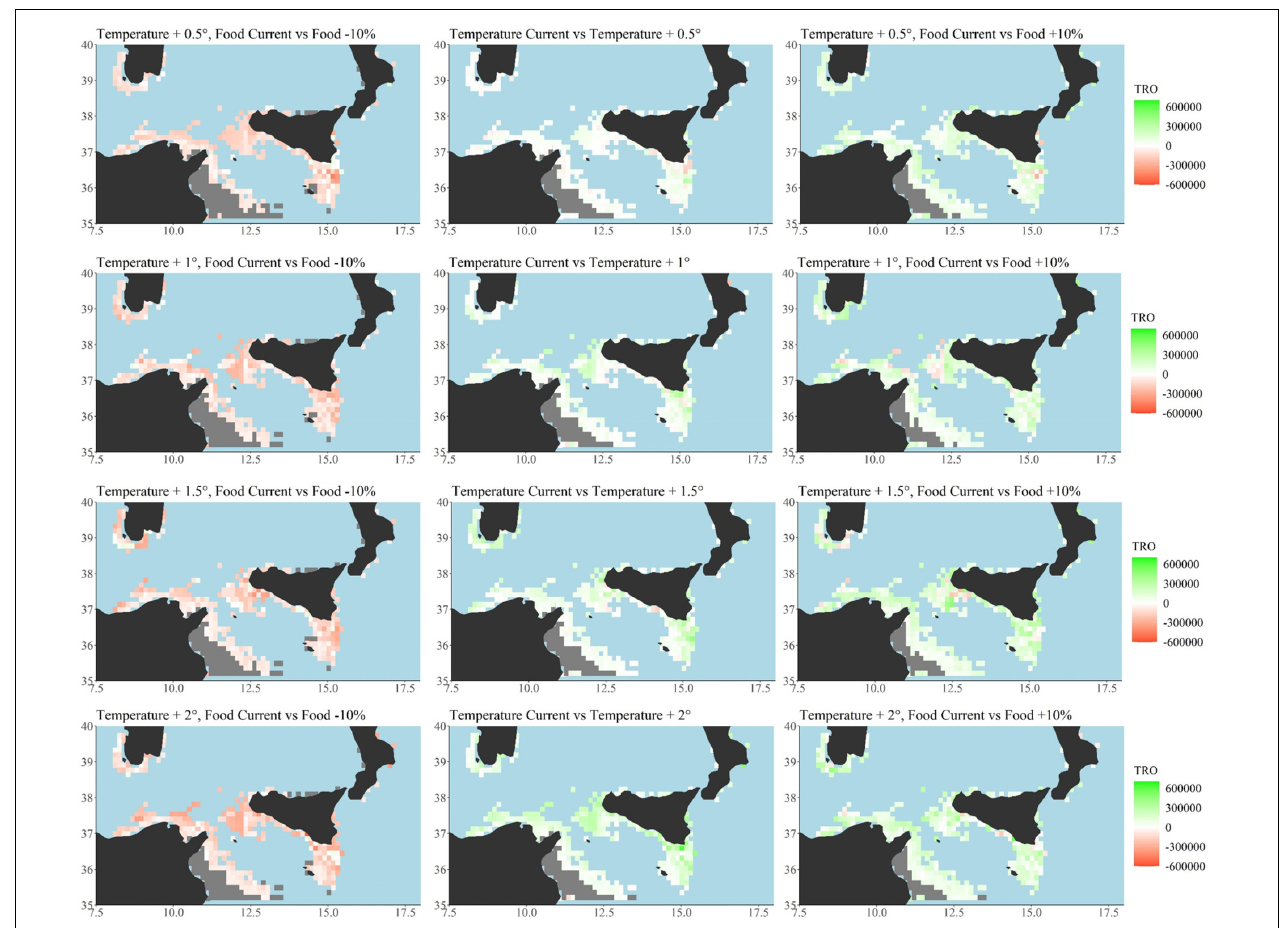
FIGURE 6 | Scenario-based quantitative maps showing differences between Total Reproductive Output (TRO, n. eggs/n. of reproductive events) described by a continuous scale (from -562,550 to 577,740) respectively across the examined temperature scenarios (central panel, current temperature vs. all the four temperature increasing scenarios of + 0.5 ◦ C increase up to + 2 ◦ C). Differences between current primary production food condition and oligotrophic, − 10%, food condition per each temperature scenarios ( + 0.5; + 1.0; + 1.5; + 2.0 ◦ C, left side). Differences between current primary production food condition and eutrophic, + 10%, food condition per each temperature scenarios (right side). Minimum, maximum, mean and median values for each scenario have been also reported as well as the global G statistic values at Supplementary Table S5 . Total number of cells = 346, cell resolution of 12.5 × 12.5 km 2 . Maps were created using R software (ggplot2